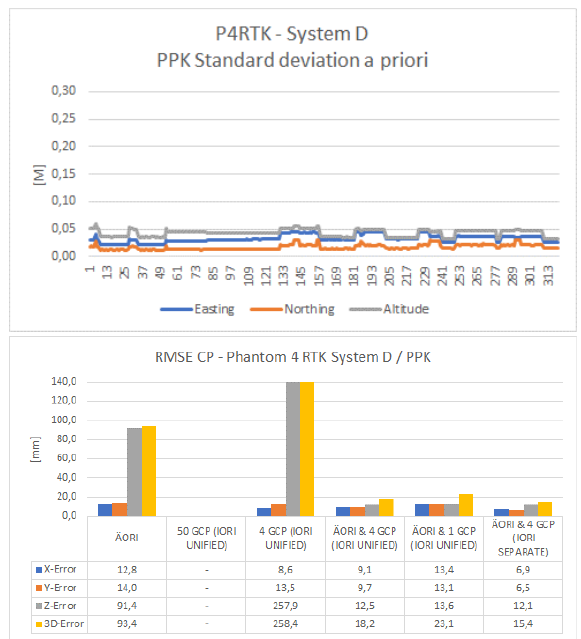
Figure 6. Evaluations based on PPK for system D: Top: Standard deviations (a priori) of the determined EO Bottom: RMSE values at the control points (CP) depending on the type of